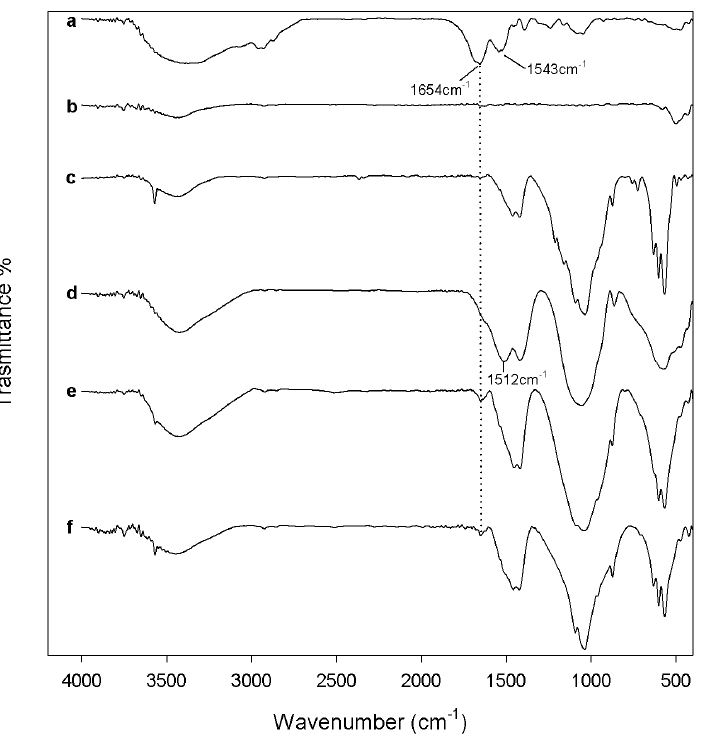
Figure 4. FTIR of ( a ) bovine serum albumin (BSA) and ( b ) ZrO 2 ; ( c ) Hap; ( d ) 9ZrO 2 ·1Hap; ( e ) 7ZrO 2 ·3Hap; and ( f ) 5ZrO 2 ·5HAp gels, heated to 600 °C, after 24 h of exposure to the BSA solution.